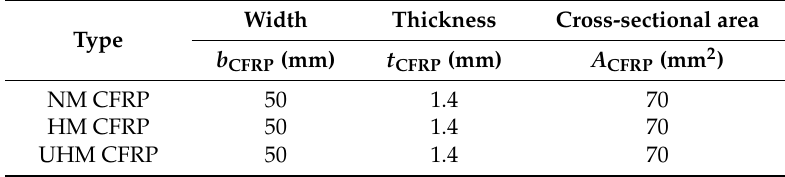
Figure 9. Measured Young’s modulus of the CFRP plates. Table 2. Geometrical properties of the CFRP plates based on the manufacturers’ data sheet.